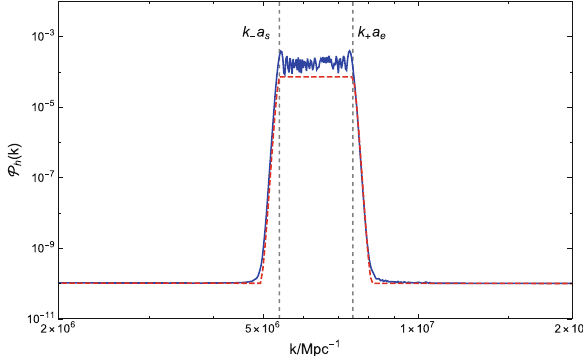
Fig. 1 The resulting tensor spectra P h for case 1 in Table 1. The red dashed and blue solid lines represent the analytical approximate and exact numerical results, respectively